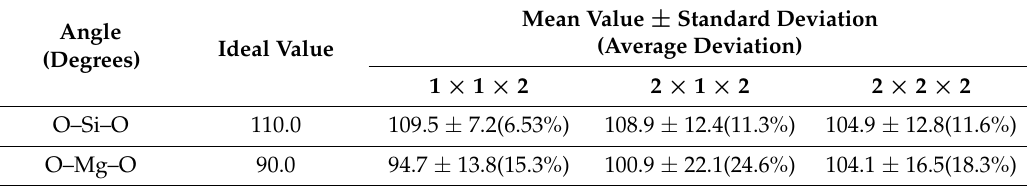
Table 3. Mean values and the corresponding average deviations (with respect to the ideal value) of the O–Si–O and O–Mg–O angles of the optimized amorphous 1 × 1 × 2, 2 × 1 × 2, and 2 × 2 × 2 Mg 2 SiO 4 systems.